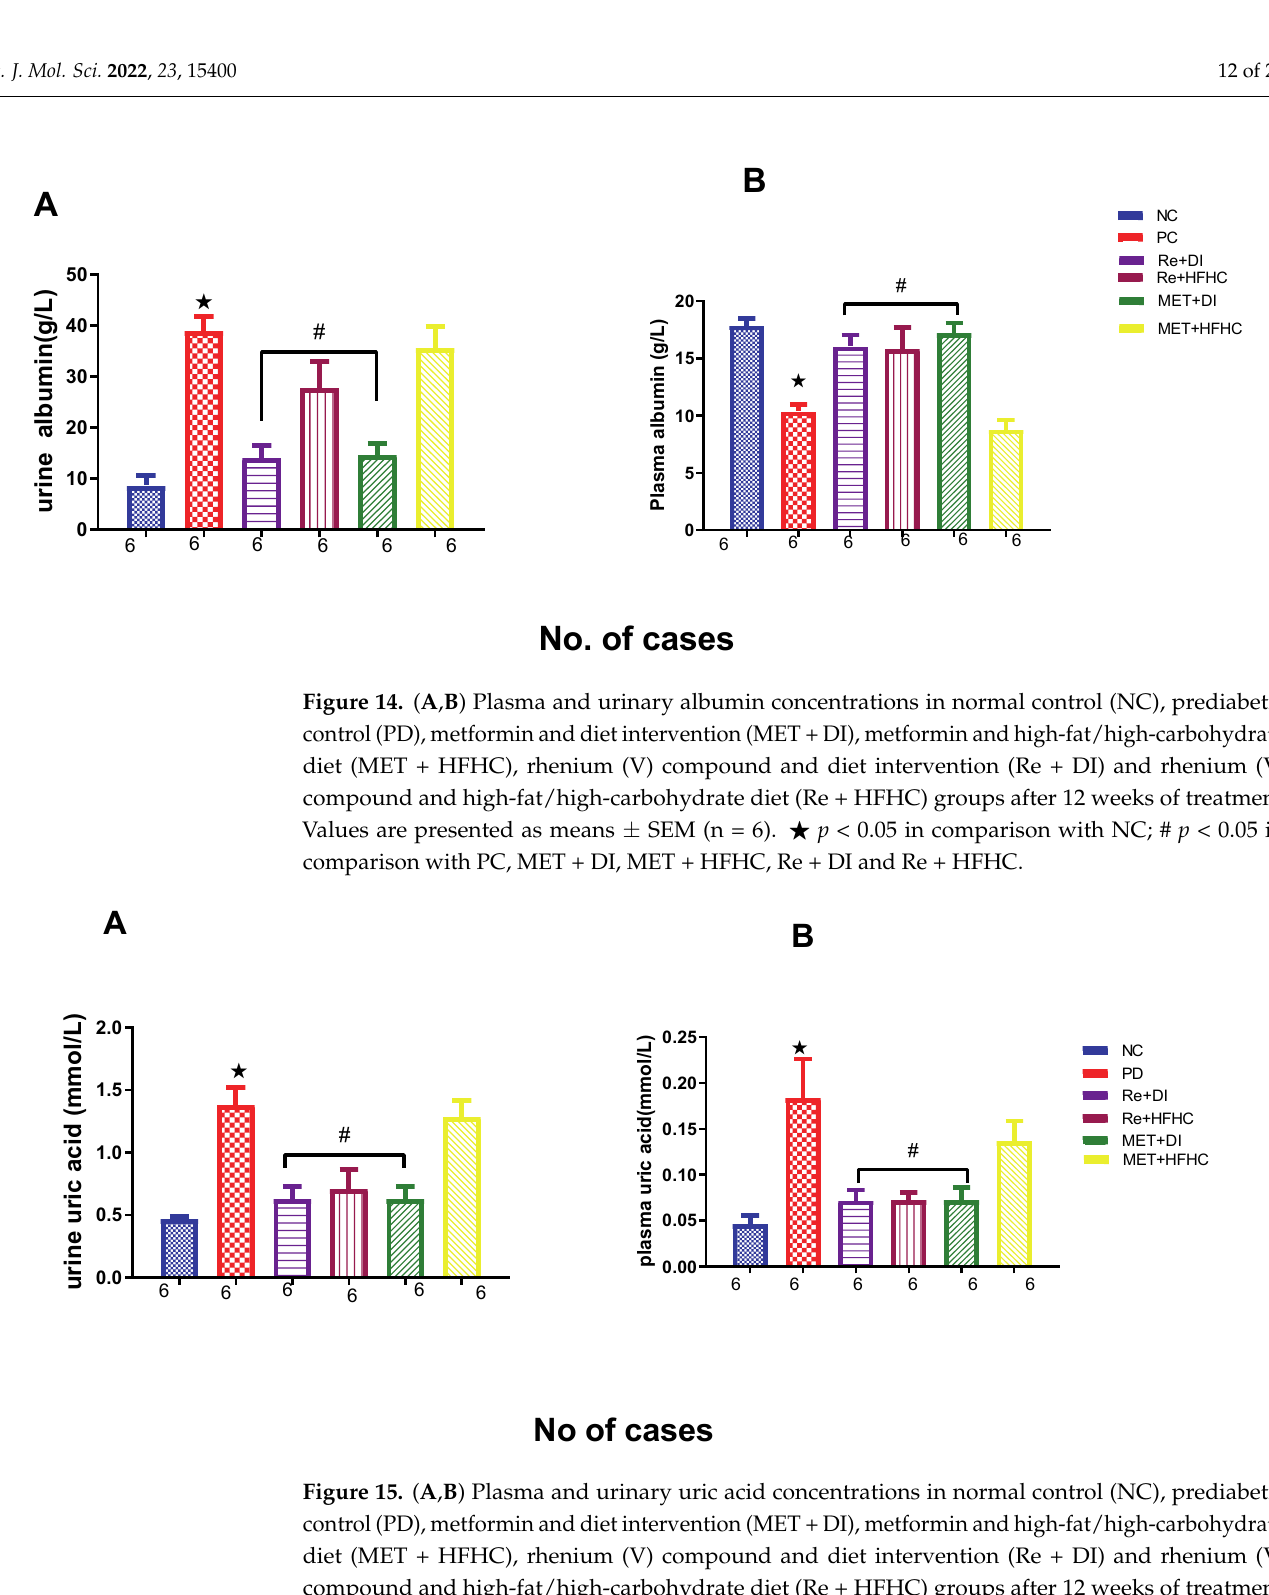
Figure 15. ( A , B ) Plasma and urinary uric acid concentrations in normal control (NC), prediabetic control (PD), metformin and diet intervention (MET + DI), metformin and high-fat/high-carbohy- drate diet (MET + HFHC), rhenium (V) compound and diet intervention (Re + DI) and rhenium (V) compound and high-fat/high-carbohydrate diet (Re + HFHC) groups after 12 weeks of treatment. Values are presented as means ± SEM (n = 6). p < 0.05 in comparison with NC; # p < 0.05 in com- parison with PC, MET + DI, MET + HFHC, Re + DI and Re + HFHC.